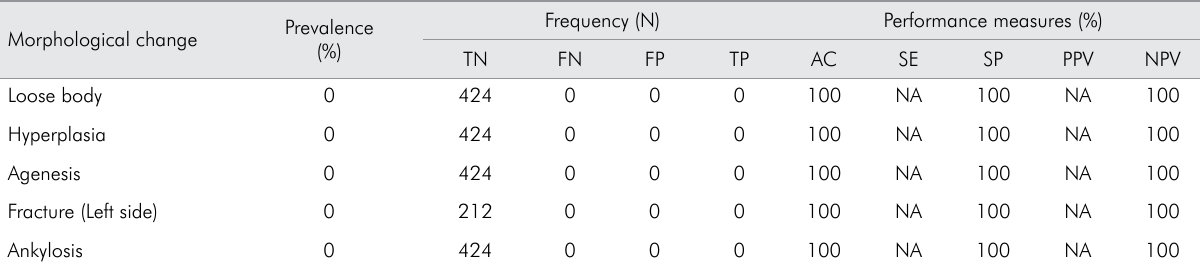
Table 1. Outcomes of the appraisers’ performance to the diagnosis considered as having a low prevalence in the sample. Morphological change